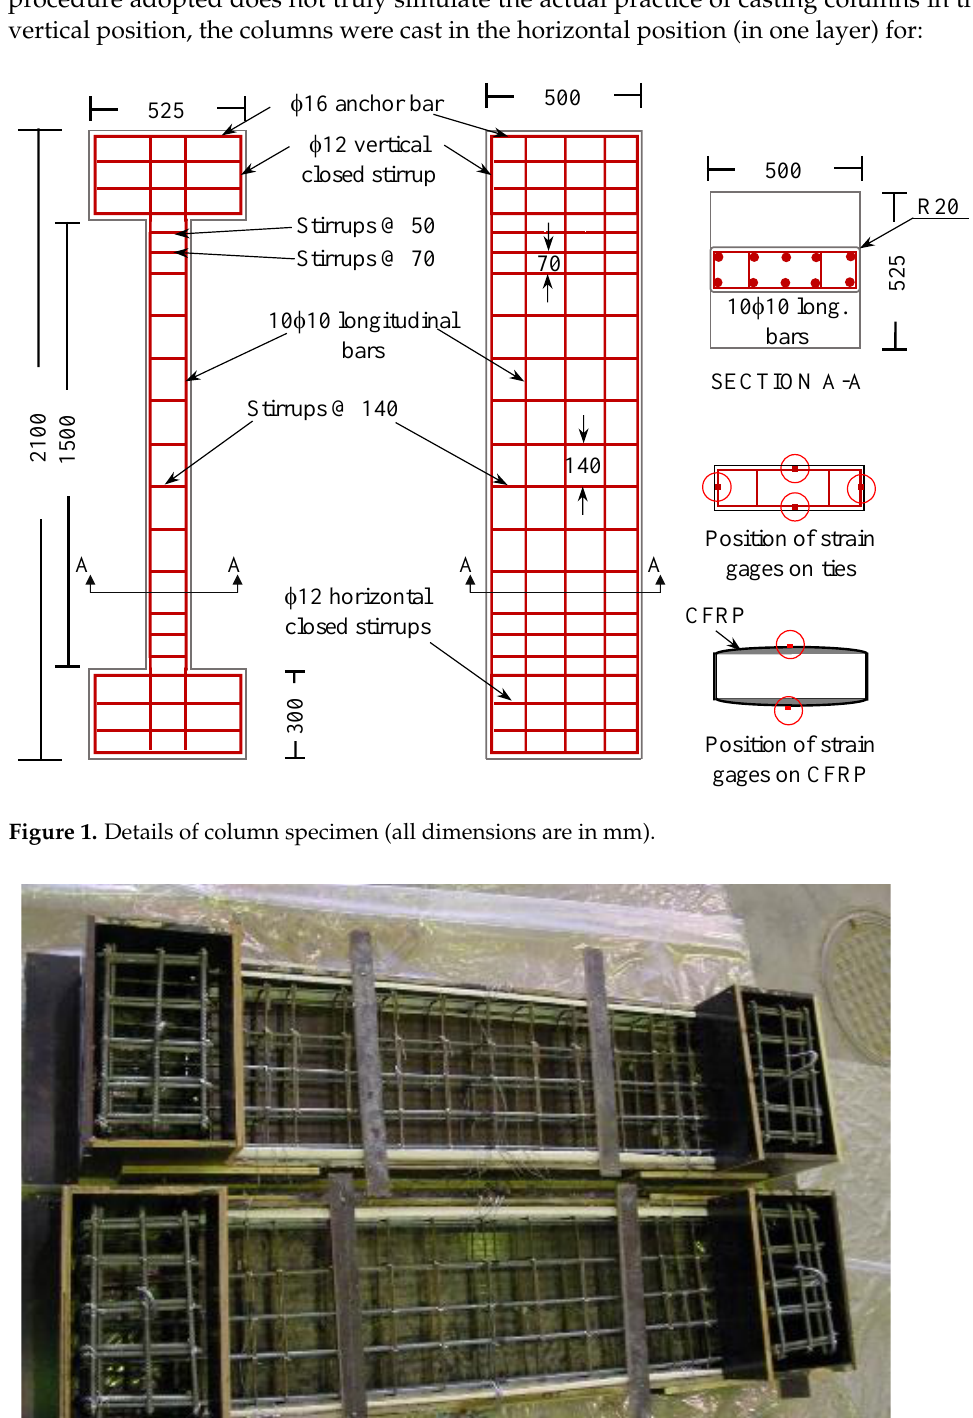
( b ) Figure 2. Casting of columns: ( a ) steel cage in wooden form ready for casting in horizontal position; ( b ) curing of column specimens. 1.